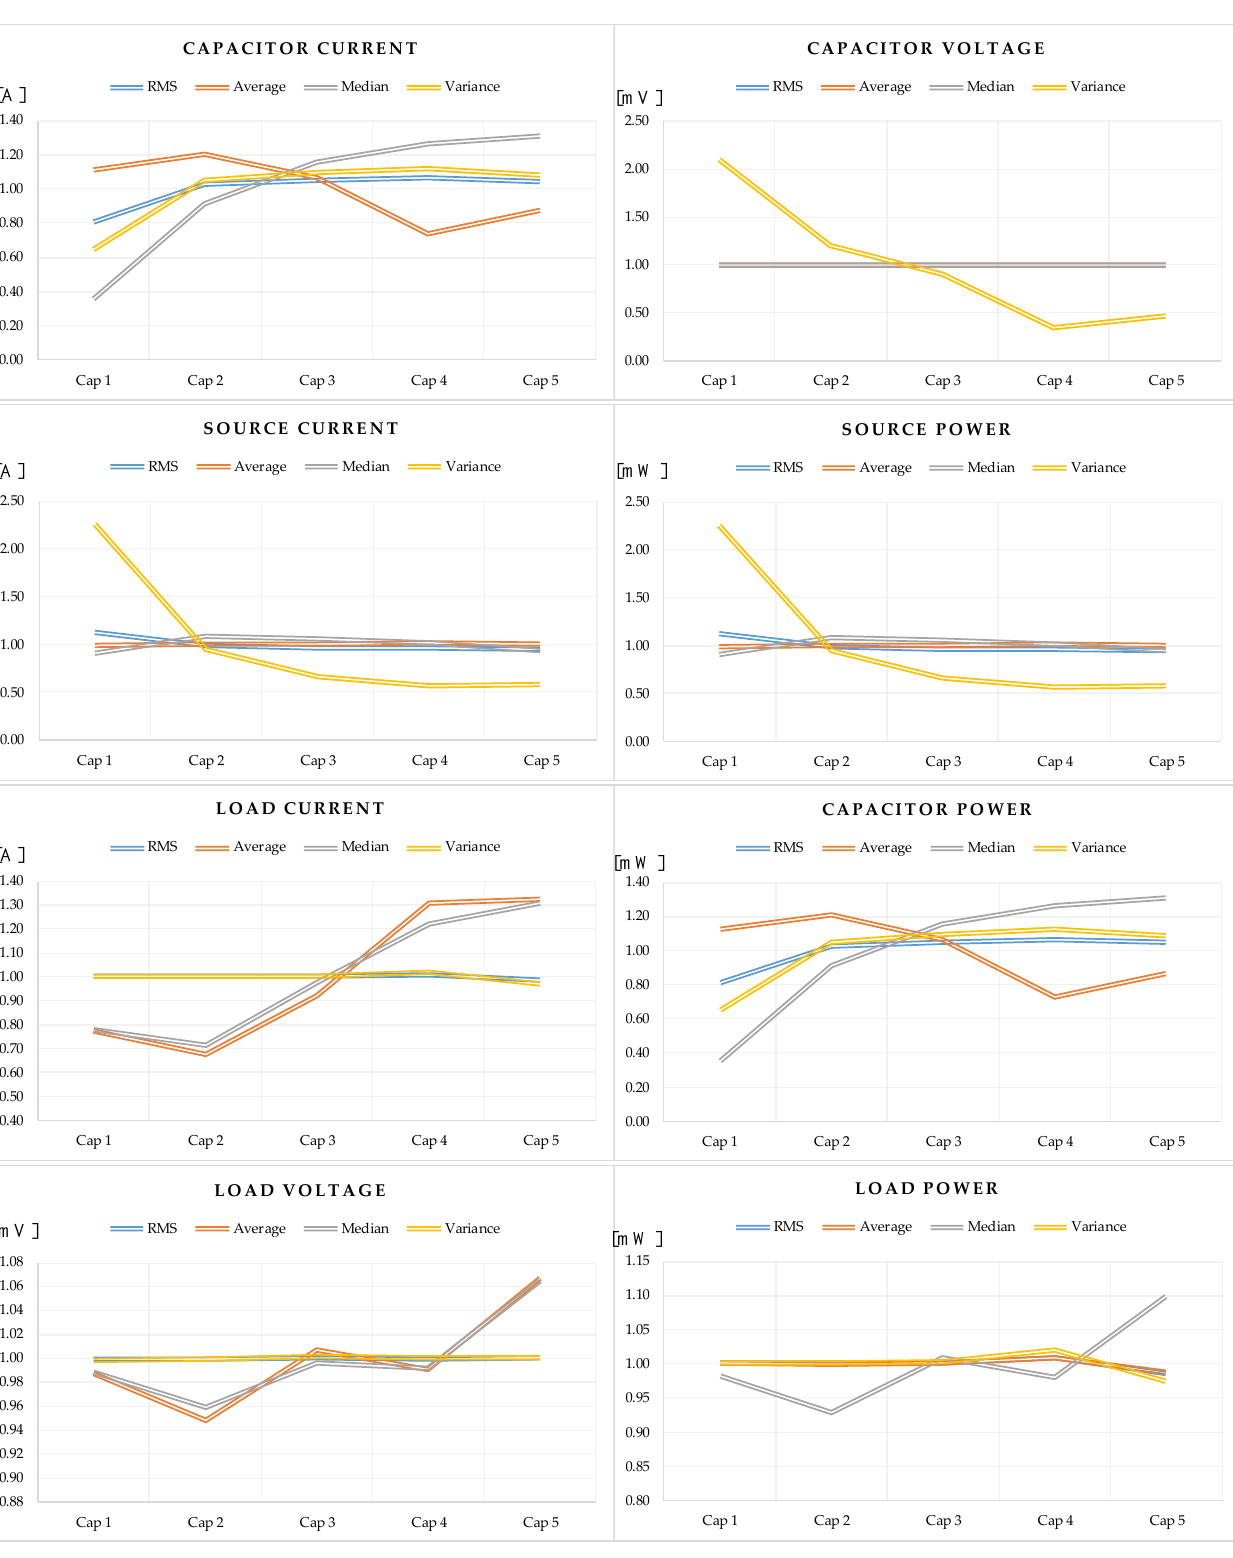
Figure 7. Normalized indexes (RMS, average, median, and variance) of different input signals using DWT analysis.